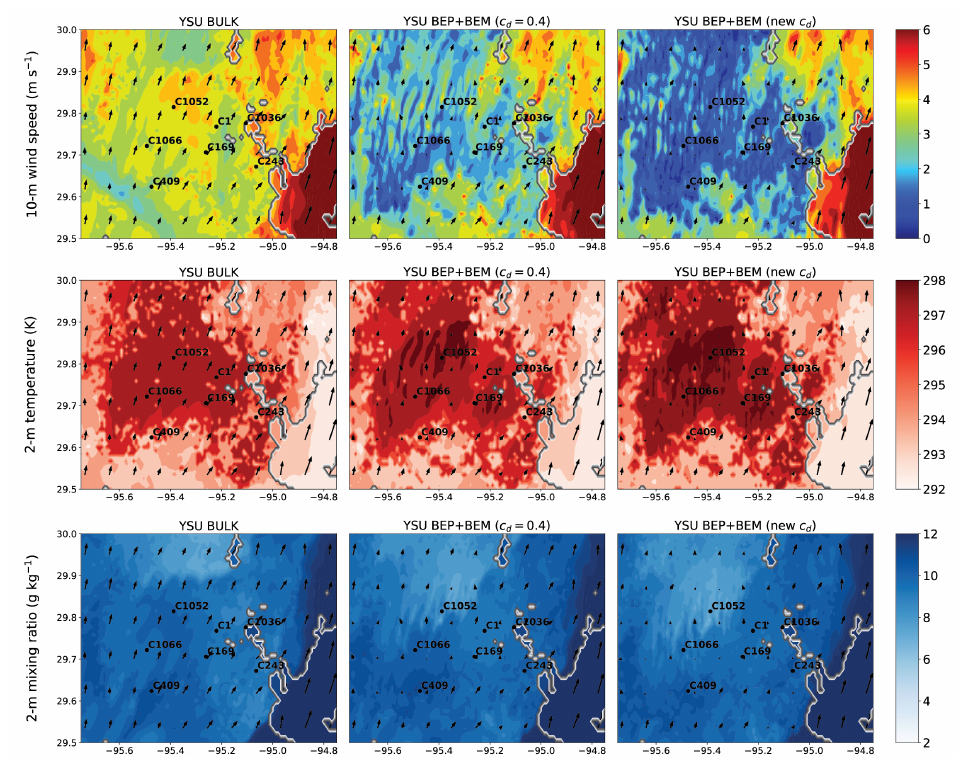
Figure 4. WRF model’s simulated near-surface fields at 12:00 a.m. UTC 22 January (7:00 p.m. LST). Vectors are shown every 10 model grid points.